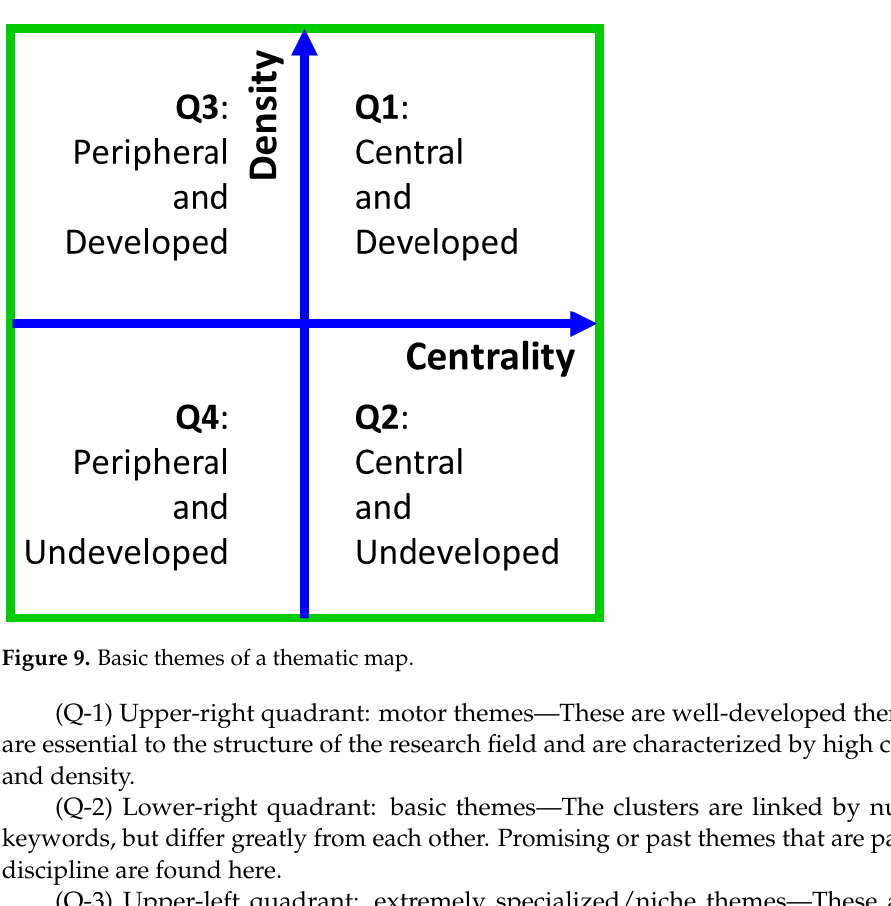
10 Figure 8. The Co-Occurrence Keyword Analysis for NIR-related literature. The figure was gener- ated using the open-source tool Biblioshiny for Bibliometrix [38]. 3.7. Thematic Map Although the keyword co-occurrence network is effective in detecting relevance and relationships, further insights are needed to capture current patterns and future research topics. Thematic maps are easy-to-use diagrams that allow us to analyse themes based on the quadrant in which they are arranged along two axes according to their centrality and density rank values. A basic thematic map looks like the figure below (Figure 9). (Q-1) Upper-right quadrant: motor themes — These are well-developed themes that are essential to the structure of the research field and are characterized by high centrality and density . (Q-2) Lower-right quadrant: basic themes — The clusters are linked by numerous key- words, but differ greatly from each other. Promising or past themes that are part of the discipline are found here. (Q-3) Upper-left quadrant: extremely specialized/niche themes — These are well-de-